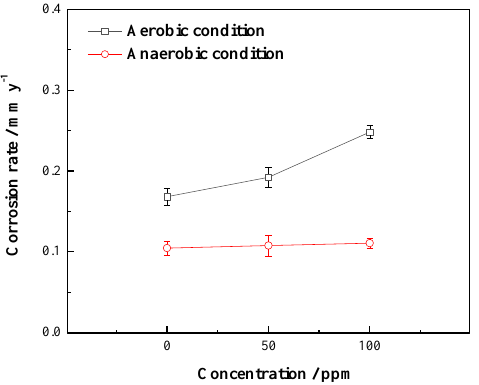
Figure 7. Corrosion rate of X80 pipeline steel with different concentrations of glutaraldehyde under aerobic and anaerobic conditions.